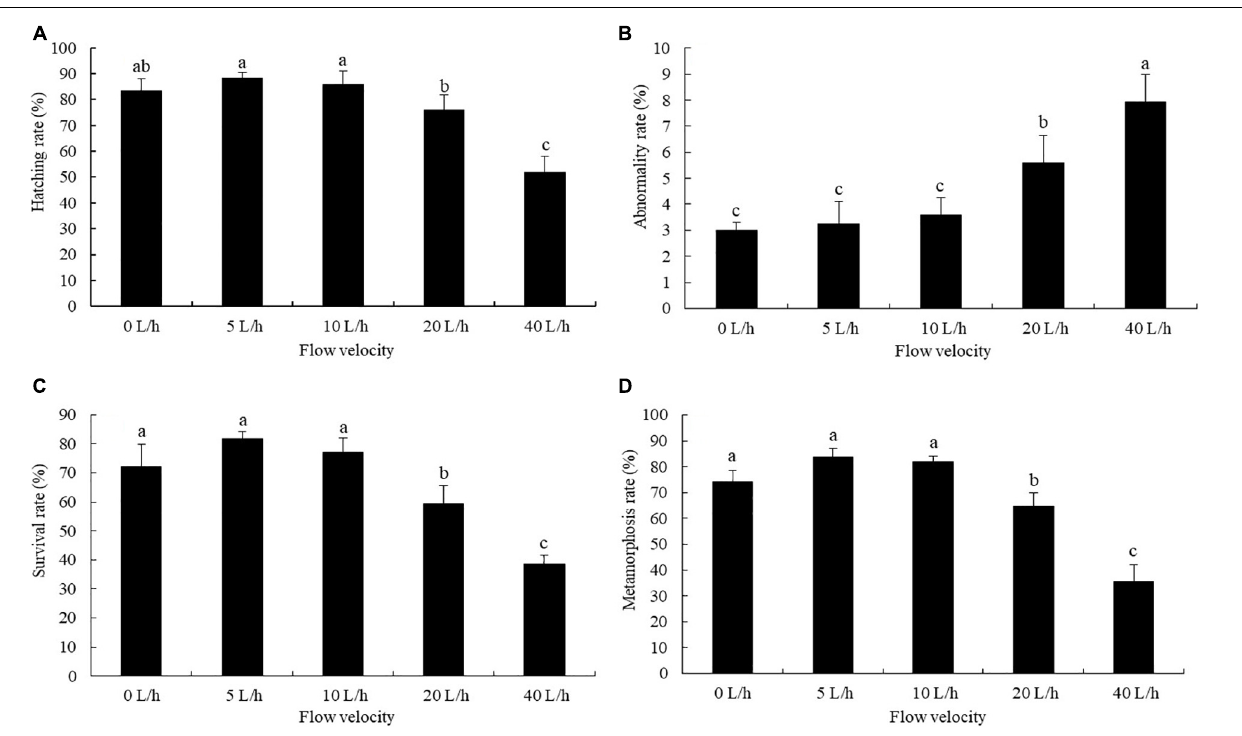
FIGURE 2 | Effects of flow velocity on the hatching rate (A) , abnormality rate (B) , survival rate (C) , and metamorphosis rate (D) of Pacific abalone H. discus hannai larvae. Values are means and standard deviation of four replicates (means ± SD; n = 4). Significant variations were found by one-way analysis of variance, P < 0.05, followed by Tukey test. Different letters denote significant differences between flow